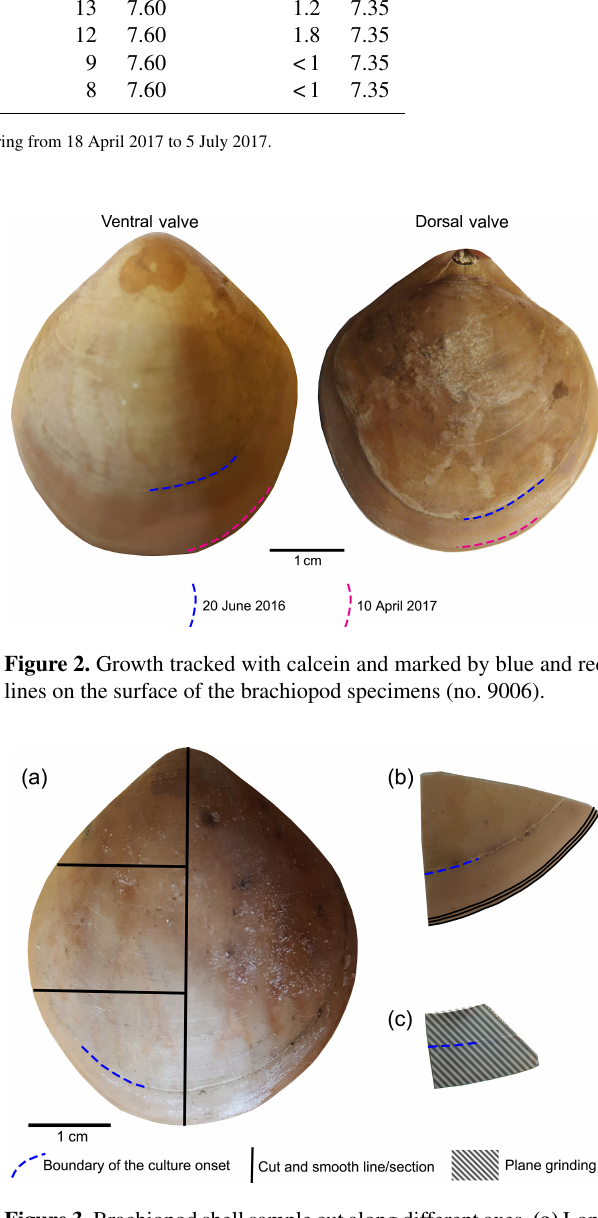
Figure 3. Brachiopod shell sample cut along different axes. (a) Lon- gitudinal and transverse sections; (b) transverse sections at the an- terior margin of the shell; (c) plane grinding of the external surface of the